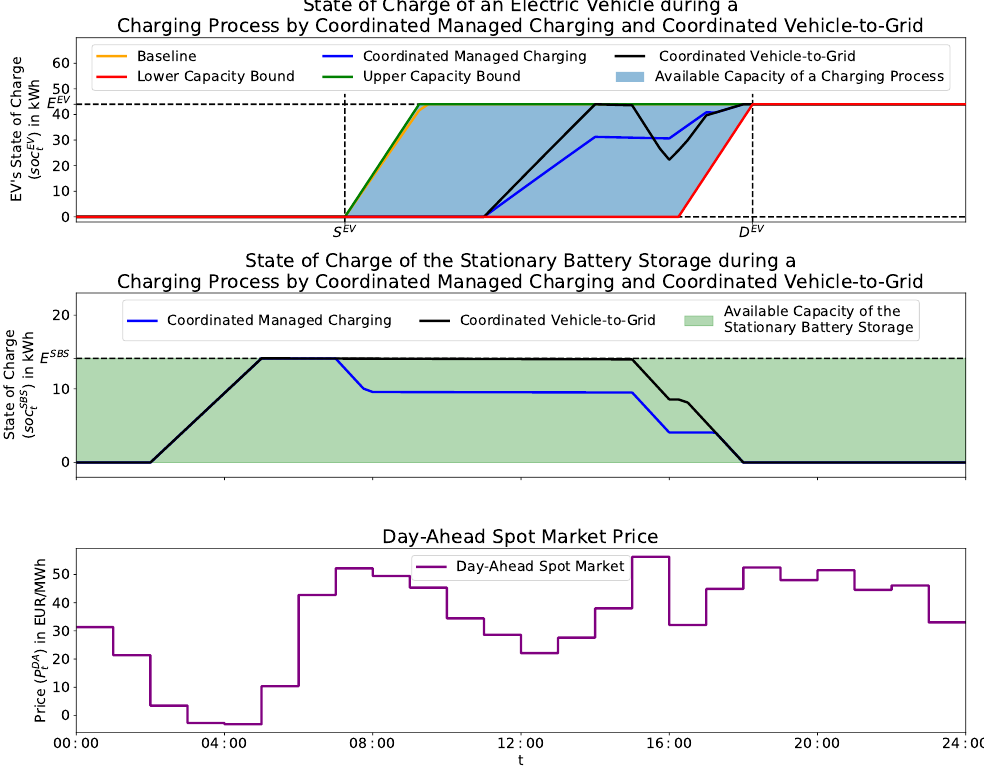
Figure 4. Charging processes of an electric vehicle with coordinated managed charging and coordinated vehicle-to-grid compared with the